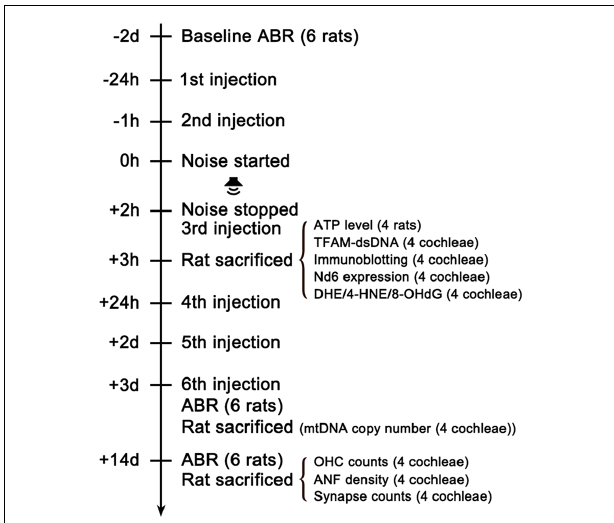
FIGURE 1 | Experimental timeline. The baseline hearing function of the rats was evaluated via ABR testing 2 days (2d) before the noise exposure. Rats were intraperitoneally injected with MT or vehicle (saline) 24 h and 1 h before the noise started. Then rats were exposed to 112dB SPL 8–16 kHz octave band noise for 2 h. The third shot was injected immediately after the noise stopped. One hour later, 12 animals in each group were sacrificed for analyses of oxidative stress level, mtDNA expression quantification, ATP measurement, immunoblotting and TFAM-mtDNA interaction. The rest of the animals received three additional injections once daily for the following 3 days. Then ABR testing were performed 3d after the noise exposure to evaluate TTS level. Then two animals in each group were sacrificed for the quantification of cochlear mtDNA copy number. After ABR testing 14d after the noise exposure for PTS level assessment, the remaining animals were sacrificed for analyses of OHC loss, IHC ribbon synapse loss and ANF degeneration. ABR, Auditory Brainstem